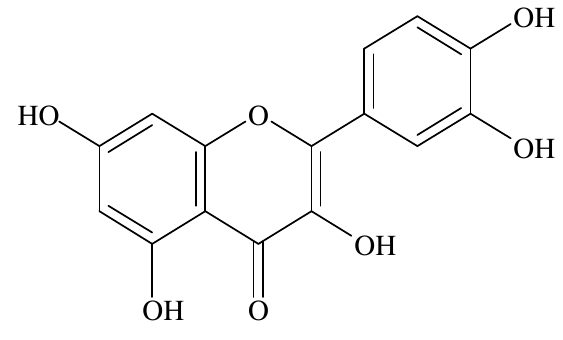
Fig. 2. Structure of quercetin Tab. 1. Bioactive compounds isolated from burnet plants